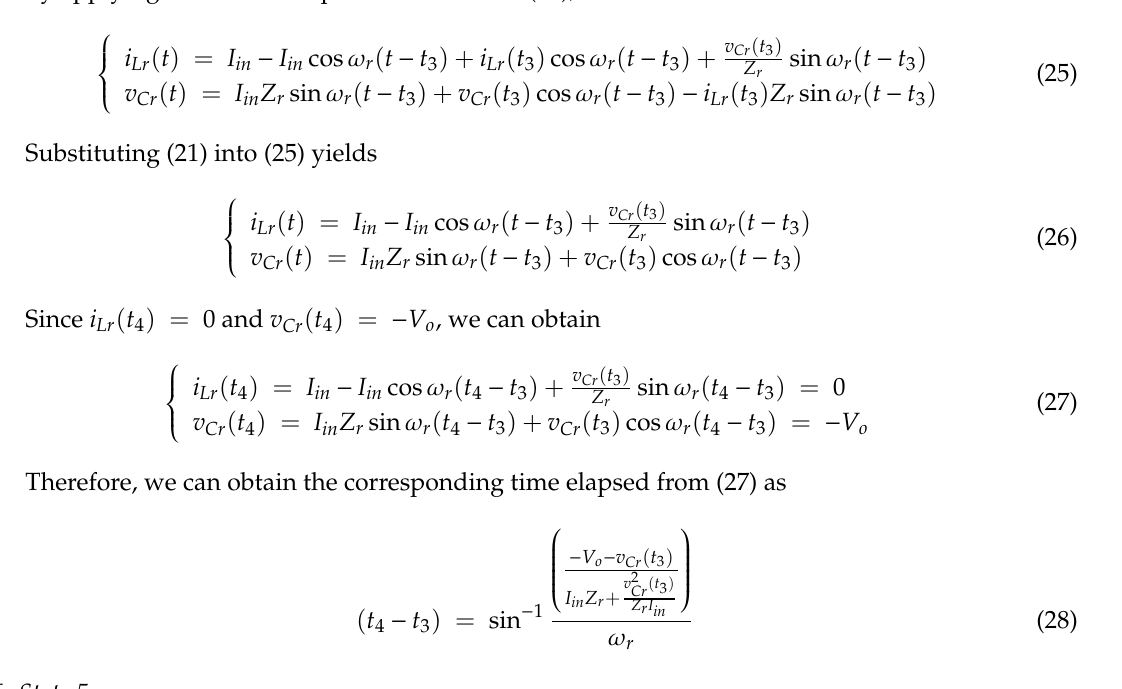
Figure 7. ( a ) Current flow in state 4; ( b ) Equivalent circuit of ( b ).